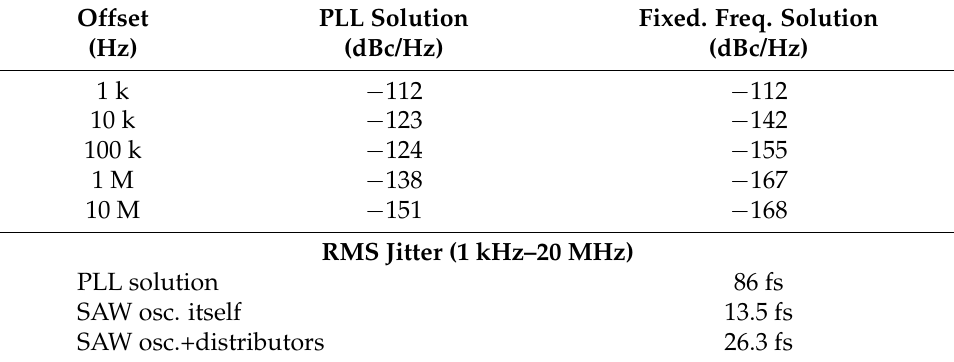
Table 3. Phase noise of clock sources at 1 GHz. (PLL: Phase Locked